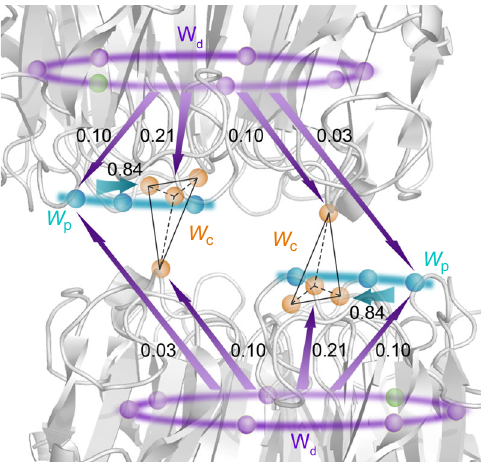
Fig. 4 A scheme of excitation-energy-transfer networks in UVR8. The two monomers are shown in gray. 6W d , 3W p , 4W c , and Y248 are shown in purple, cyan, orange, and green spheres, respectively. Arrows show excitation-energy fl ow directions from the distal ring to the interfacial peripheral outliers and pyramid centers, and from the peripheral outlier to the pyramid center. The corresponding values are the branching fractions for their energy-transfer